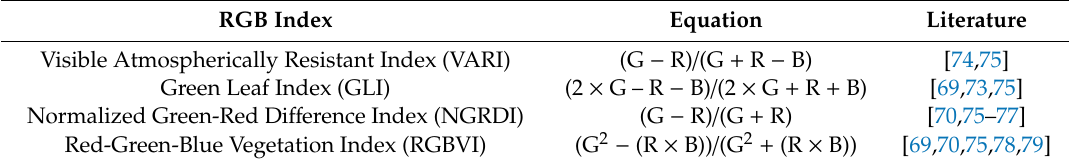
Table 1. RGB indices calculation using RGB bands (R: red, G: green, B: blue band’s pixel intensities). RGB